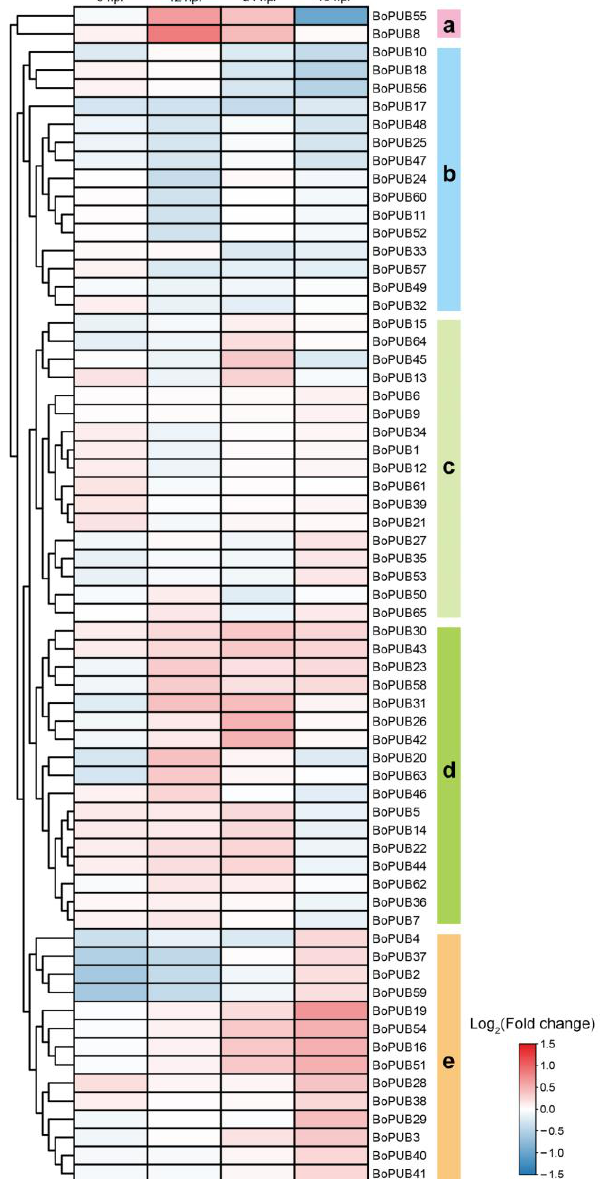
Figure 9. Expression profiles of BoPUB genes after Alternaria brassicicola infection. The expression data of BoPUB genes were obtained from the microarray gene expression data of cabbage leaves at 0, 12, 24, and 48 h post-infection (hpi) by Alternaria brassicicola . Fold changes in the expression levels of BoPUB genes were plotted in a log2-scaled heatmap. Each row and column in the color heatmap indicate a single gene and time point, respectively, and their names are shown. BoPUB genes are hierarchically clustered into five groups (Groups a–e) according to their expression levels. Groups a to e are highlighted in five different colors,